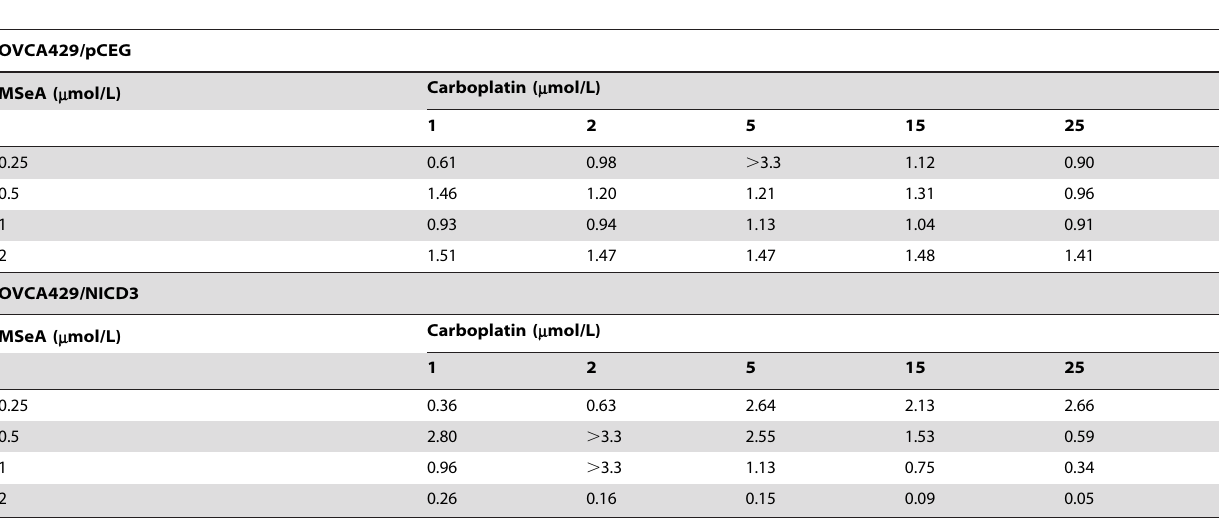
Table 2. Combination index (CI) values for MSeA and carboplatin treatment in OVCA429/pCEG and OVCA429/NICD3 ovarian cancer